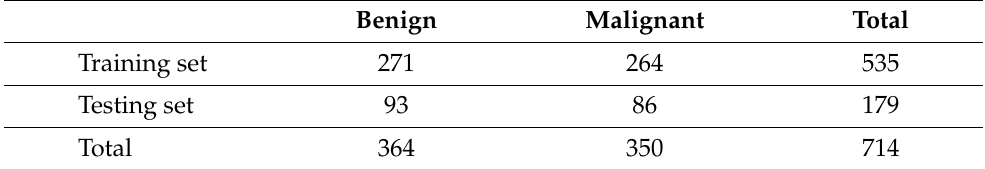
Table 9. Number of samples for each class after applying SMOTE.